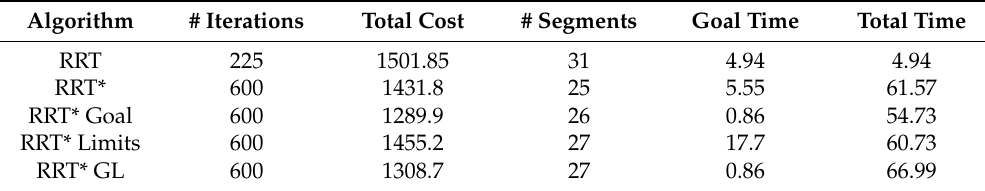
Table 5. Results. One obstacle, 600 iterations.